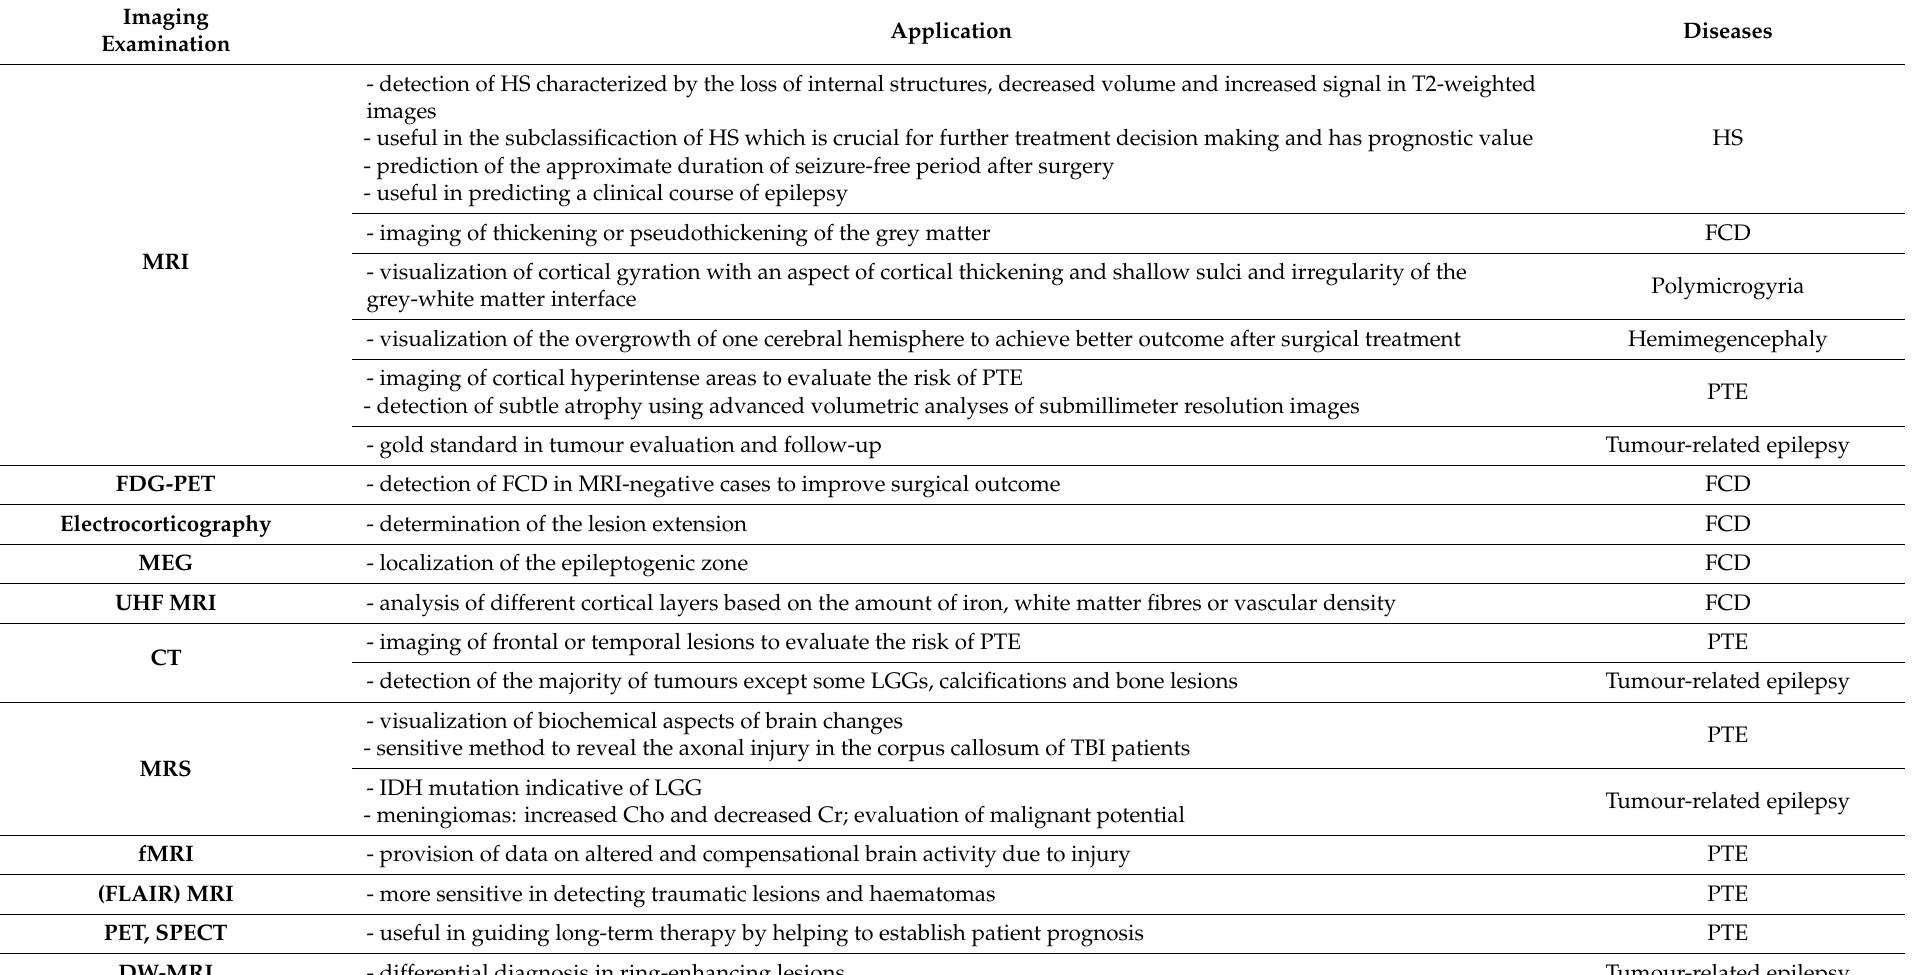
Table 1. The most common imaging